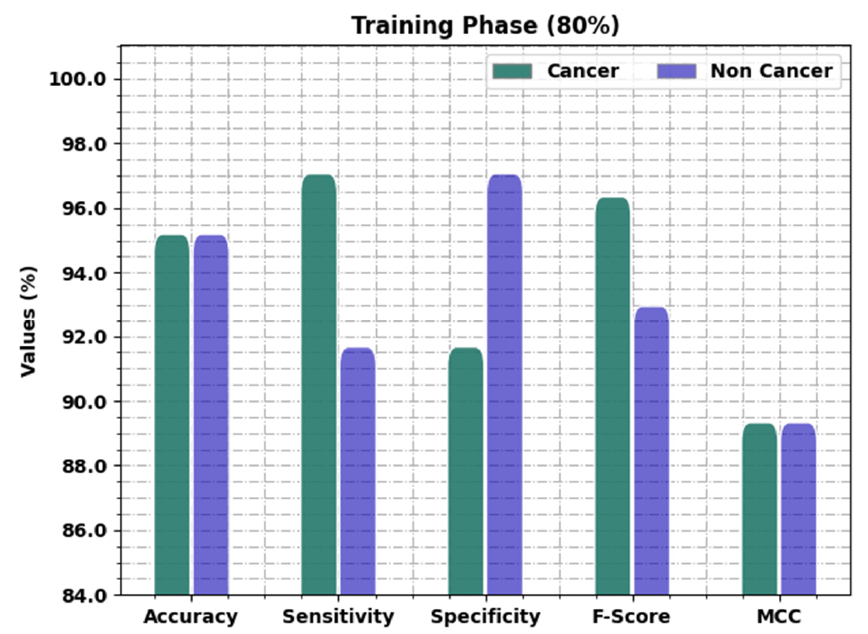
Figure 4. Result analysis of OIDCNN-OPMDD approach under 80% of TR data.